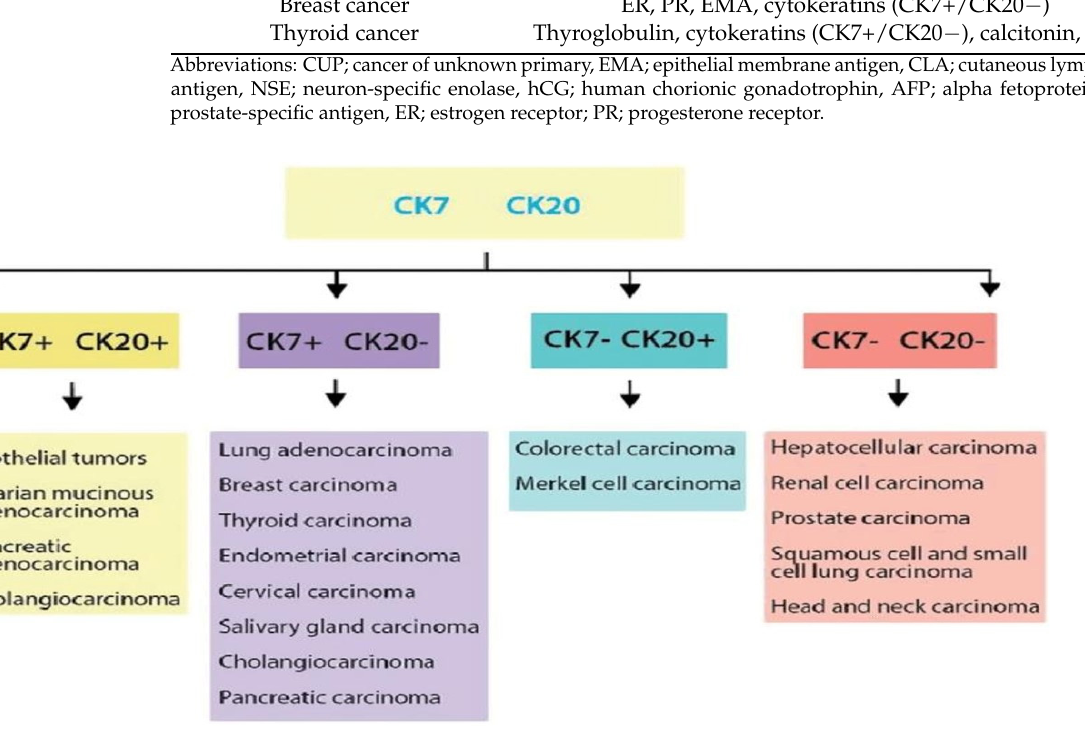
Figure 2. Cytokeratins used in CUP.